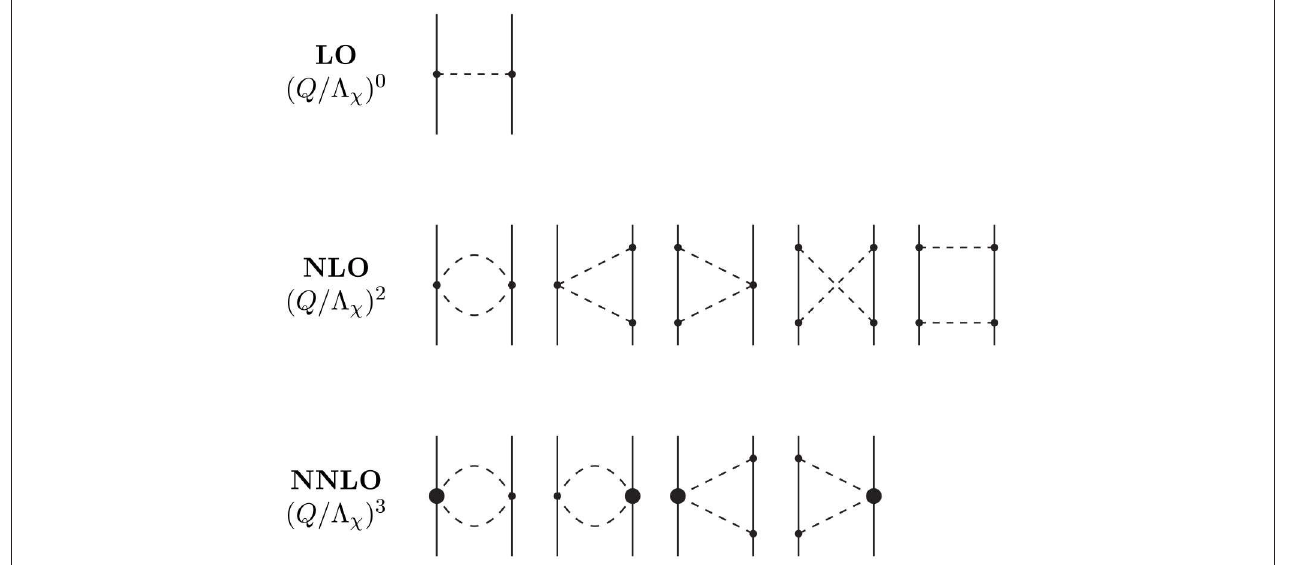
FIGURE 2 | LO, NLO, and NNLO contributions to the NN interaction. Solid lines represent nucleons and dashed lines pions. Small dots and large solid dots represent vertices with index 1 i 0 and 1, respectively. Reprinted figure with permission from Entem et al. [ 46], copyright (2015) by the American Physical =